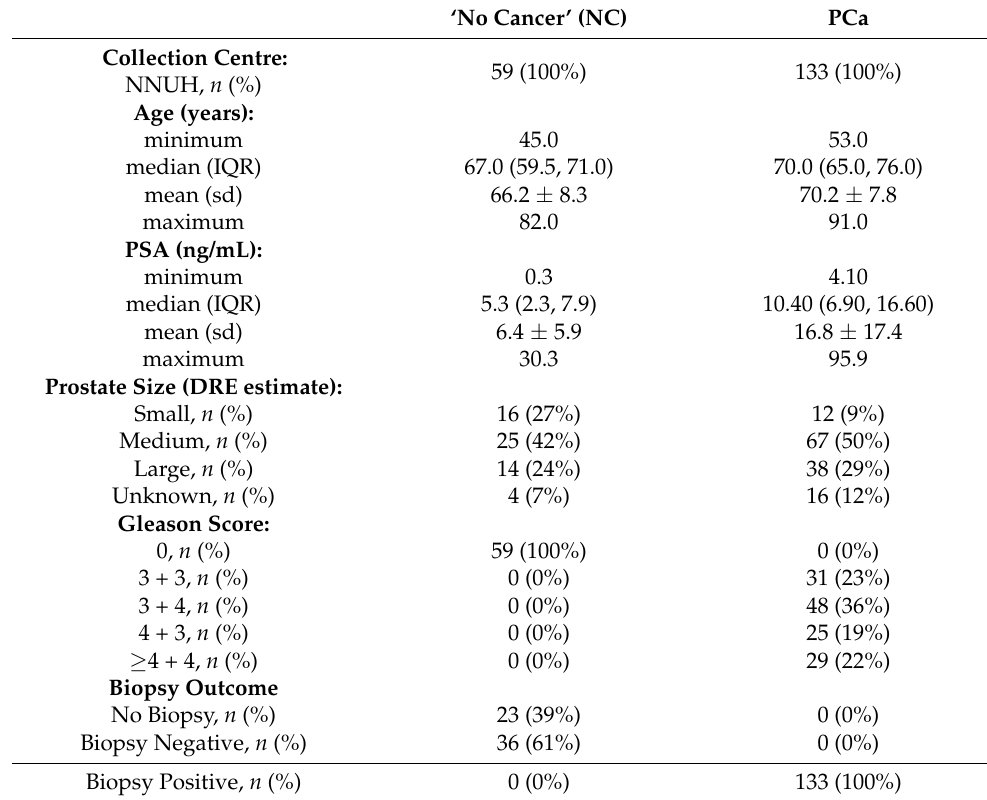
Table 1. Characteristics of the ExoSpec development cohort subdivided into ‘No Cancer’ (NC) and prostate cancer (PCa) patients—see Methods. ‘No Cancer’